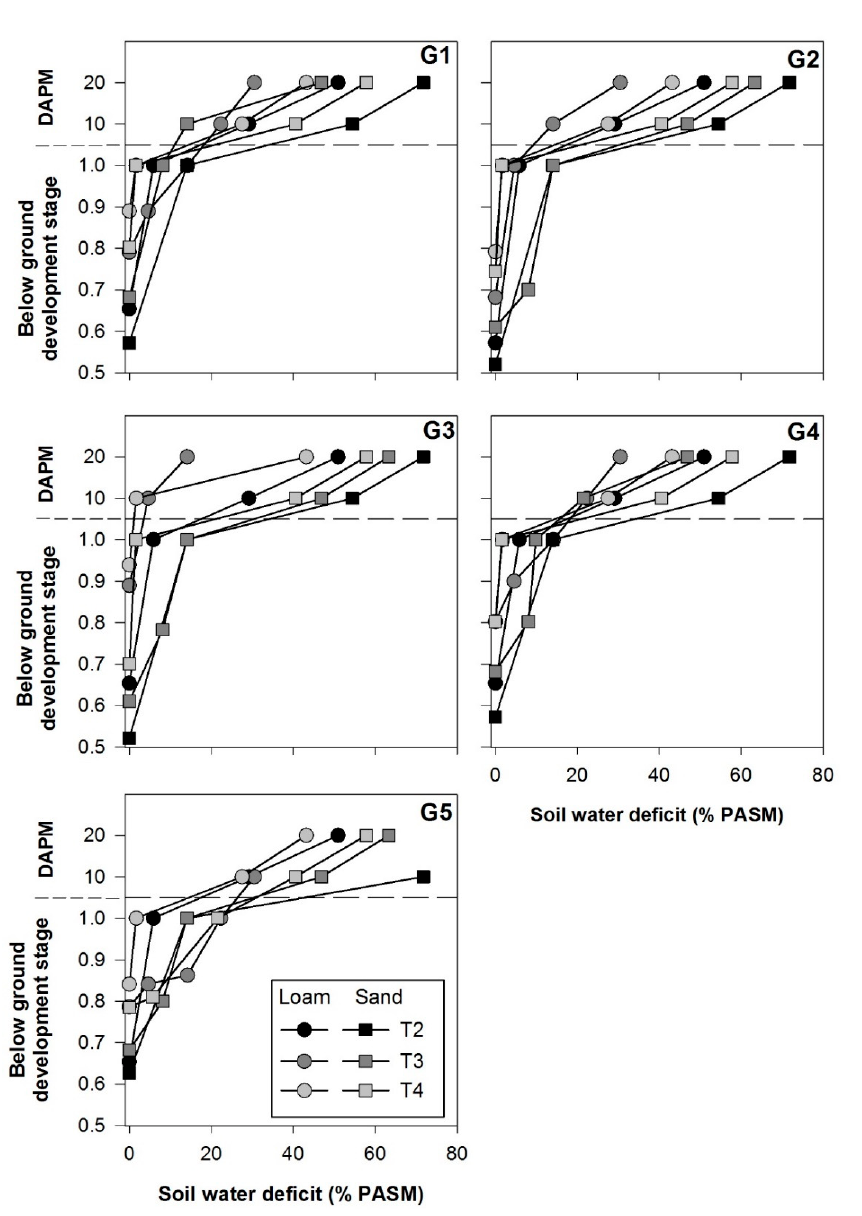
Figure 4. Below ground phenology and soil water deficit in the percent of plant available soil moisture (PASM) of five potato clones grown on two soil types (loamy sand: Loam; sandy soil: Sand) under the three drought treatments. Treatment details are given in Section 2.3 and Table 4. Additional destructive samplings 10 or 20 days after the stage of physiological maturity (DAPM) were included where applicable.